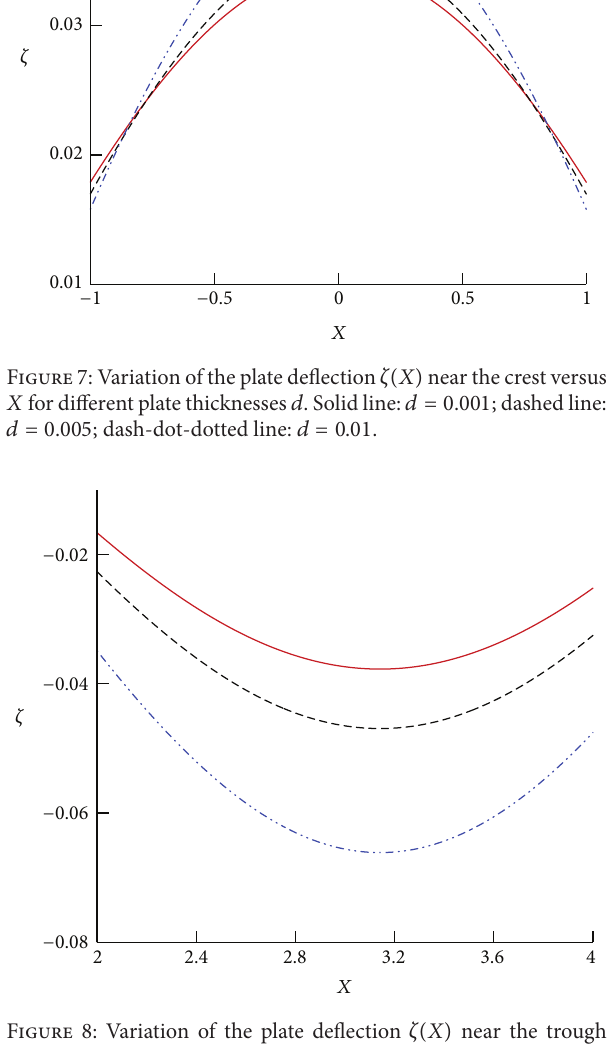
depths. And with an increasing Young’s modulus of the plate, the wave energy becomes large too.